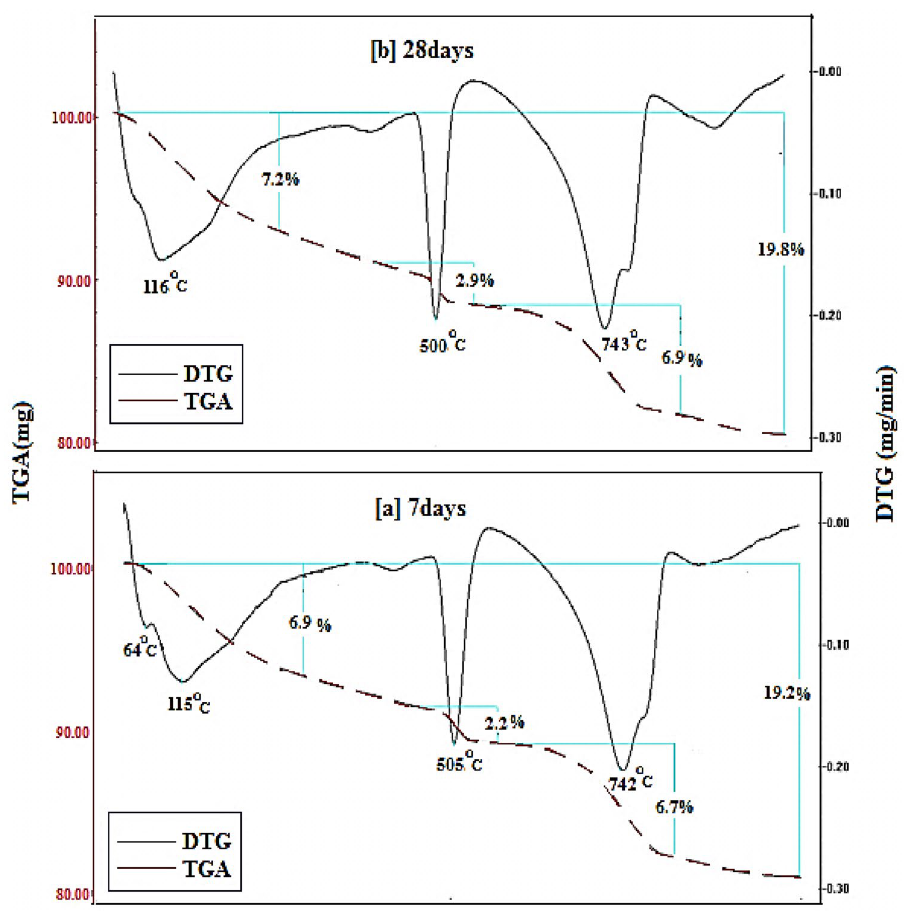
Figure 16. TGA/DTG thermograms of hardened specimens made from mix ANMFs0.5 at ( a ) 7 days and ( b ) 28 days